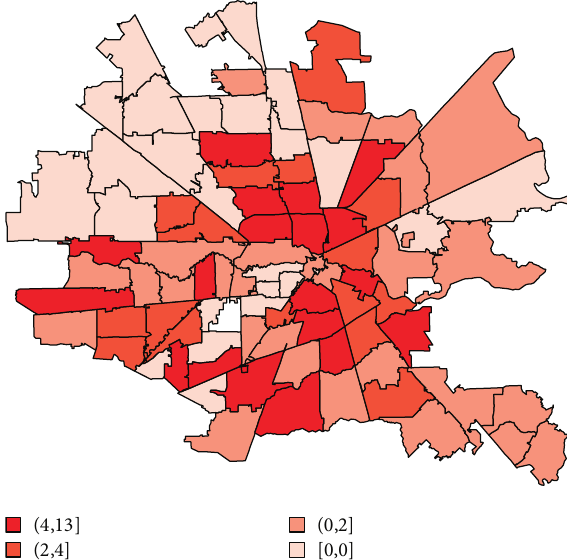
Figure 4: Poor neurological outcome after cardiac arrest by the Houston metro zip code ( N �